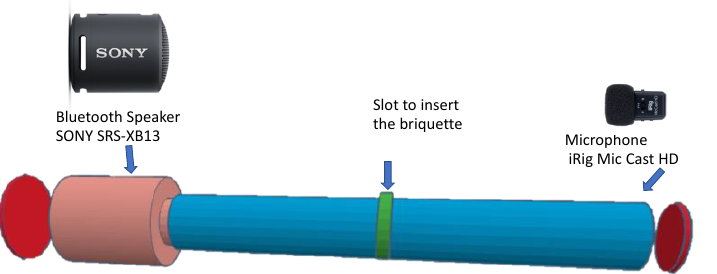
Figure 4. Scheme of the equipment to measure sound.